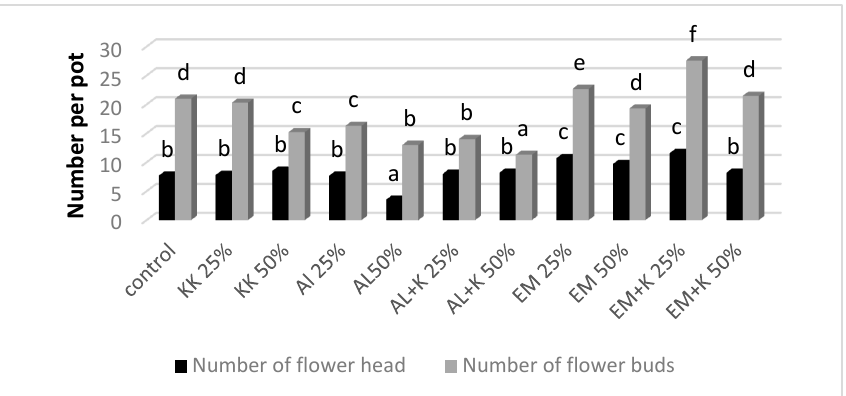
Figure 2. The influence of medium on flowering plants. Means followed by the same letters do not differ significantly at p =